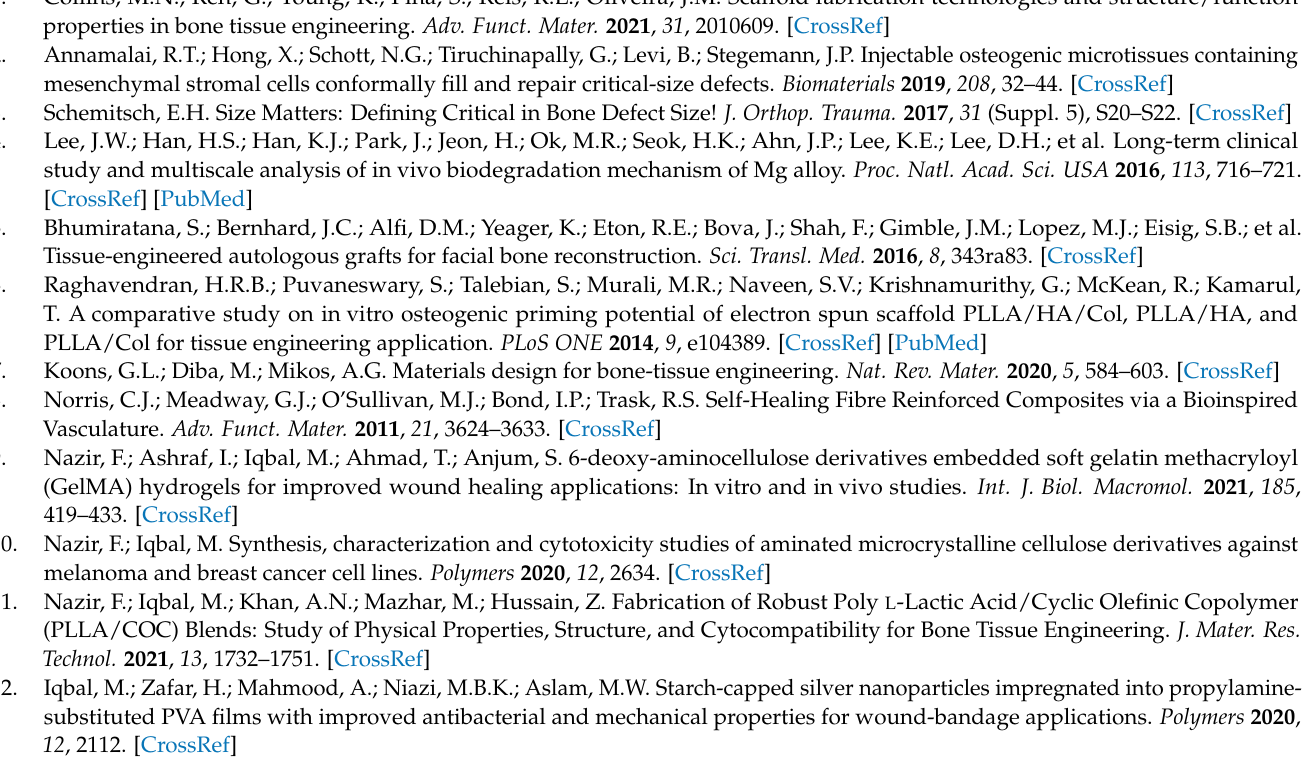
method. Figure S2: Antimicrobial activity of PLLA, COC, PLLA/nHA, PLLA/10% COC/nHA with (a) E. coli , (b) Pseudomonas aeruginosa , (c) Staphylococcus aureus and (d) Listeria monocytogenes . Table S1 PLLA/COC-nHA and PLLA-nHA nanocomposites composition prepared in 40 mL of